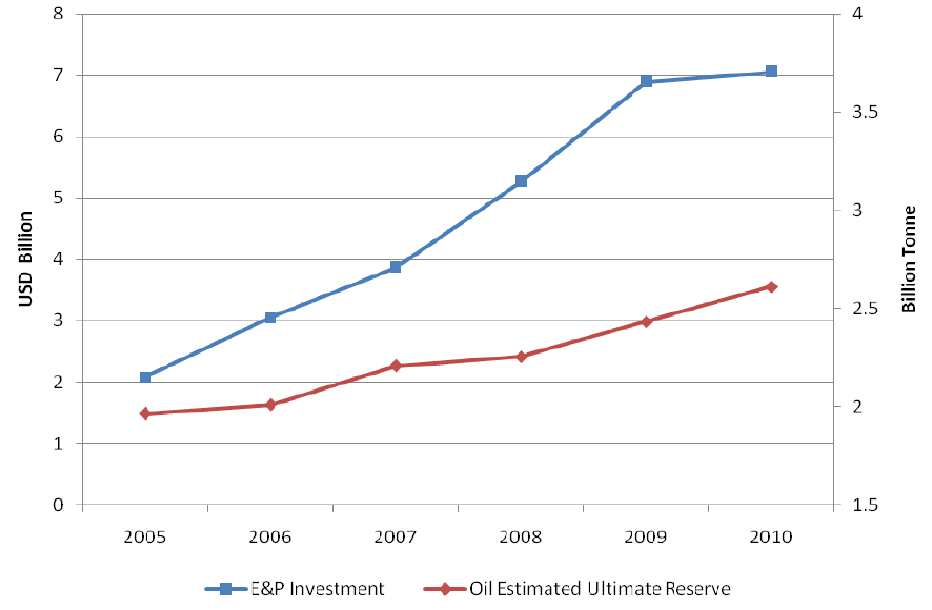
Figure 6. Investment and ultimate reserve growth (data source: BGR and Petronas